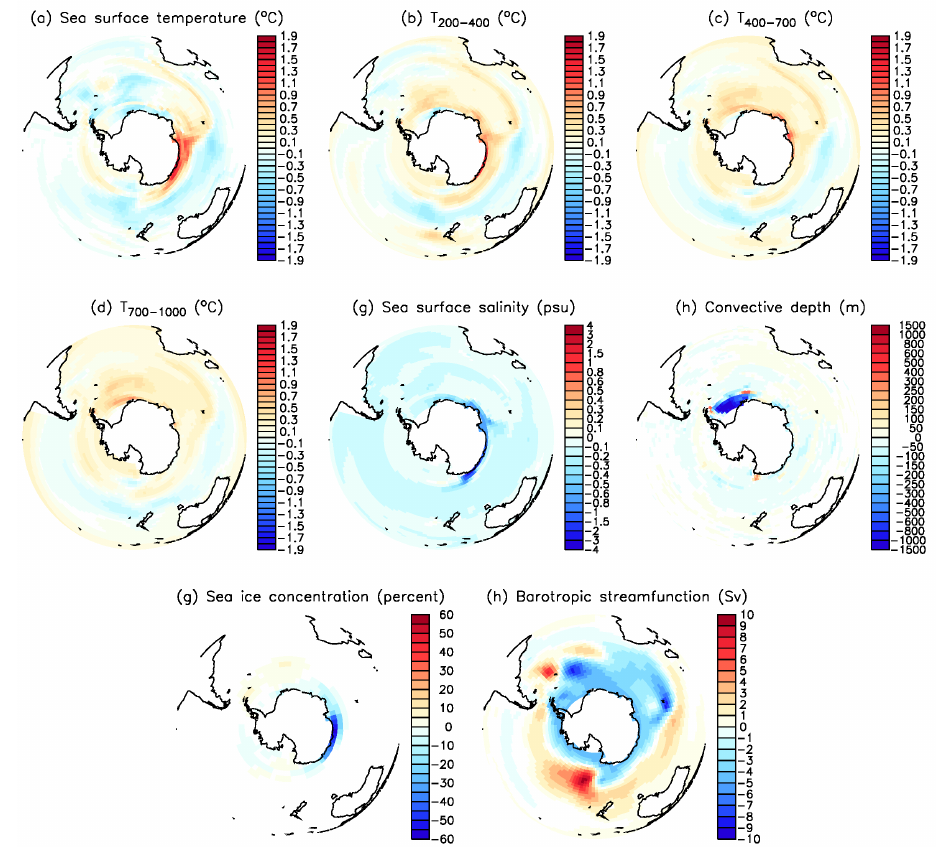
Figure 7. As Fig. 5, but for experiment